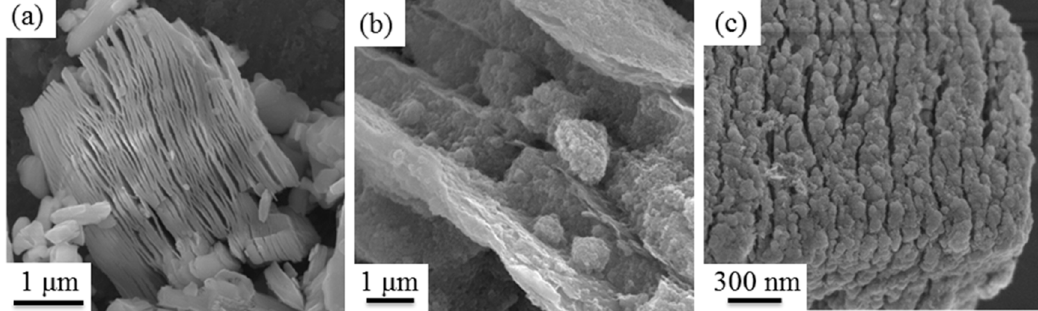
Figure 2. SEM images of ( a ) pure Ti 3 C 2 T x MXenes, ( b ) precursor of 2 wt.% Ti 3 C 2 T x /NiZn ferrite composites, and ( c ) after hydrothermal treated at 200 ° C of precursor of 2 wt.% Ti 3 C 2 T x /NiZn ferrite composites.